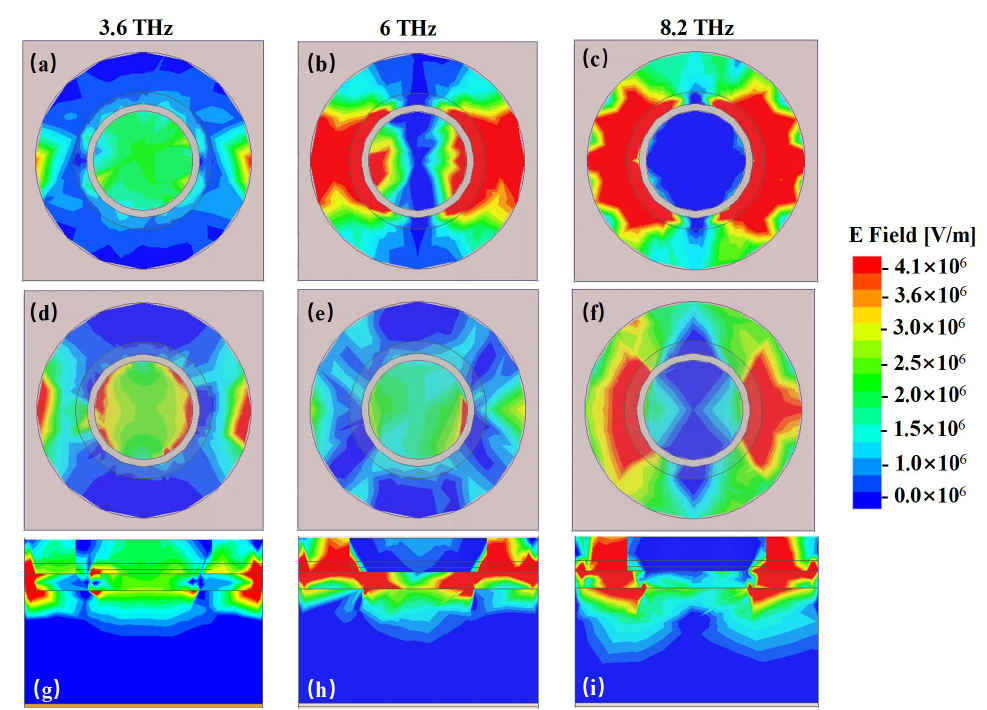
Figure 4. The simulated electric field distribution of the top graphene layer at ( a ) 3.6 THz, ( b ) 6 THz, ( c ) 8.2 THz and bottom graphene layer at ( d ) 3.6 THz, ( e ) 6THz, ( f ) 8.2 THz and side view of electric field at ( g ) 3.6 THz, ( h ) 6 THz, ( i ) 8.2